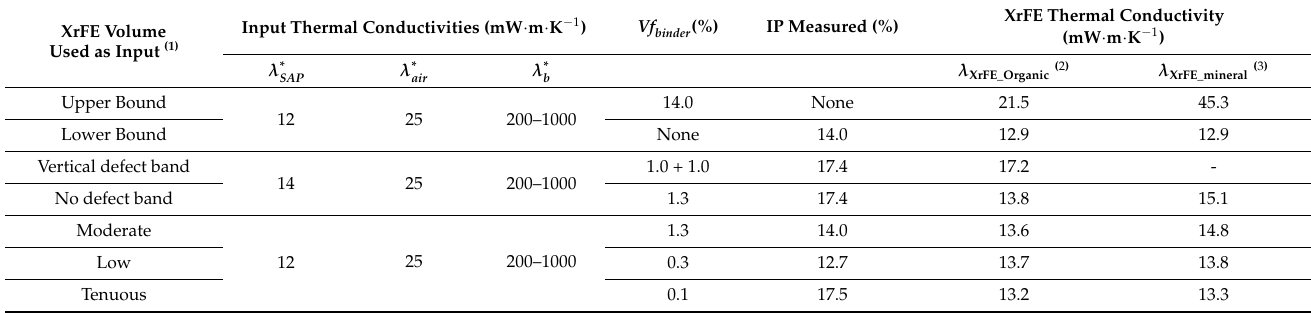
Table 5. Binder and IP parameter study, inputs and XrFE simulated conductivities.